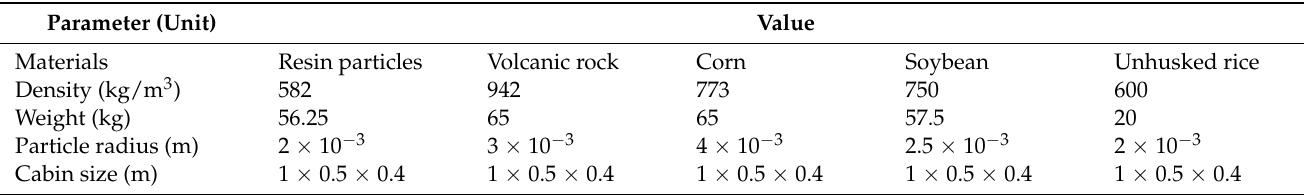
Table 1. Record of experimental